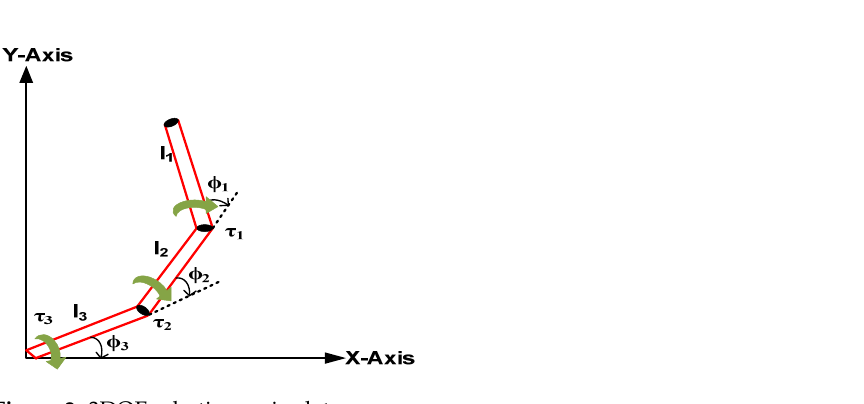
Figure 2. 3DOF robotic manipulator.